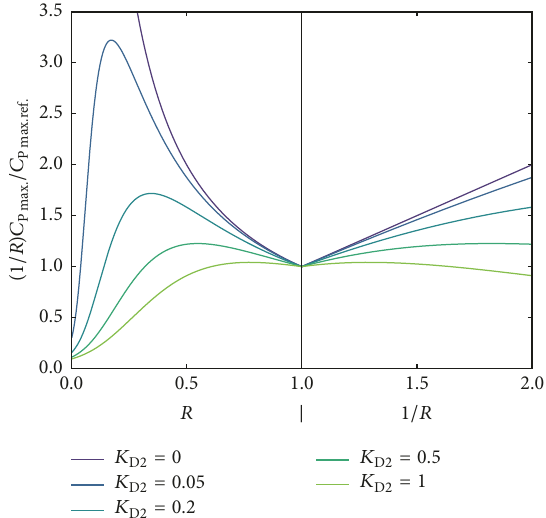
to its Pmax . = when 𝐾 D 2 D 0